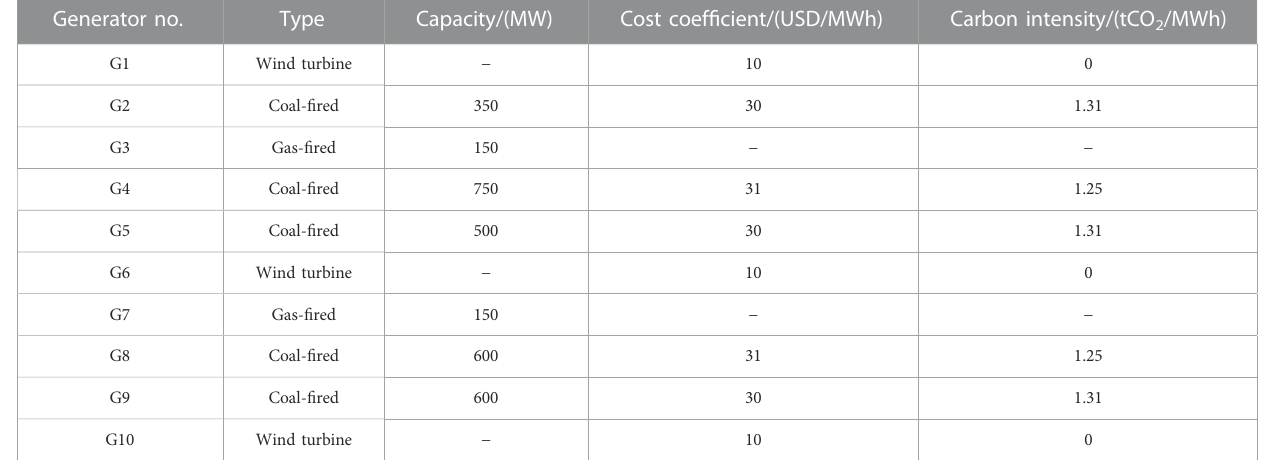
TABLE 1 Parameters of generators. Generator